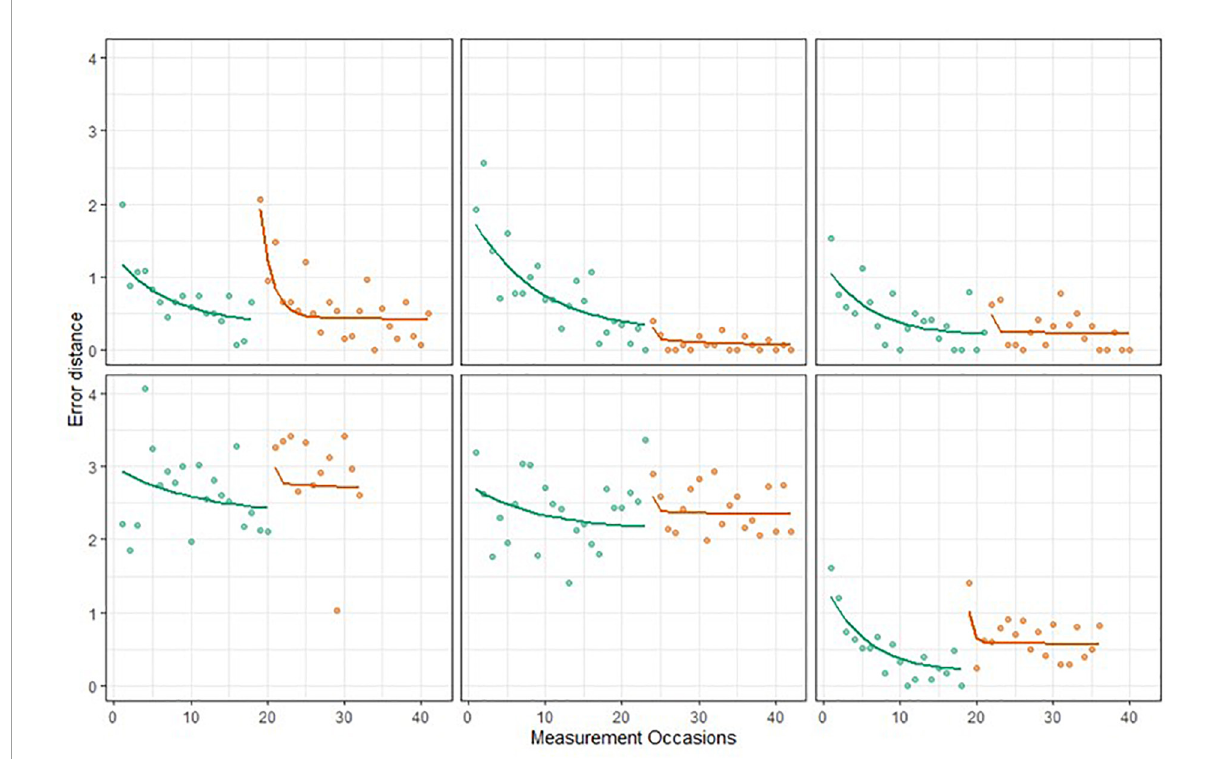
FIGURE7 Six EAS participants’ grid memory data and predicted Bayesian double exponential model (BDEM)